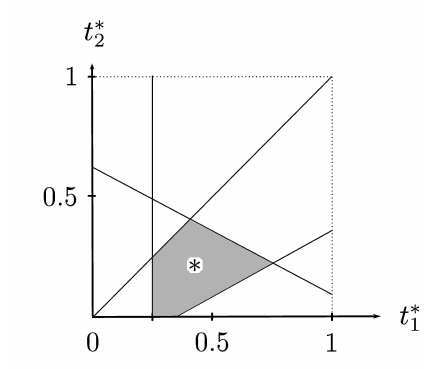
We see the rather complicated domain for the legal equilibria (shaded area) and the unique illegal equilibrium in the midst of it. In a similar case